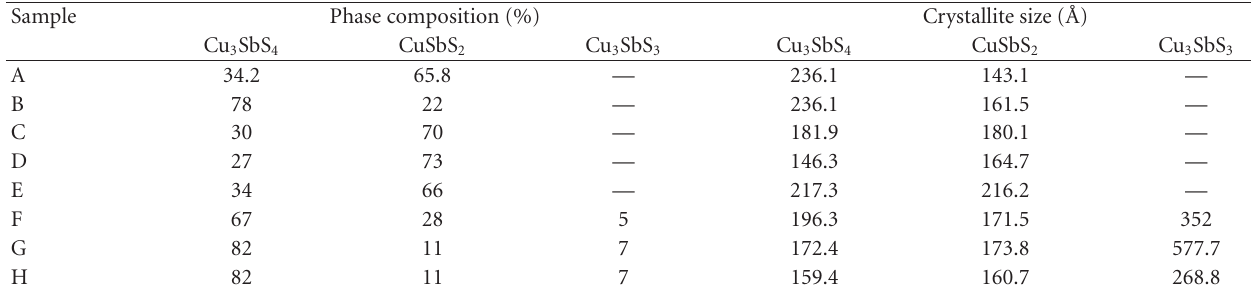
Figure 3: FTIR reflectance spectra for samples F, G, H: (a) for films, (b) for precursor solution. Table 2: Crystallite size and phase composition for samples